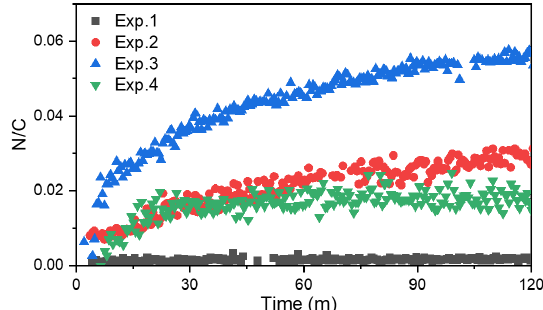
Figure 7. The evolution of N / C in different experiments.